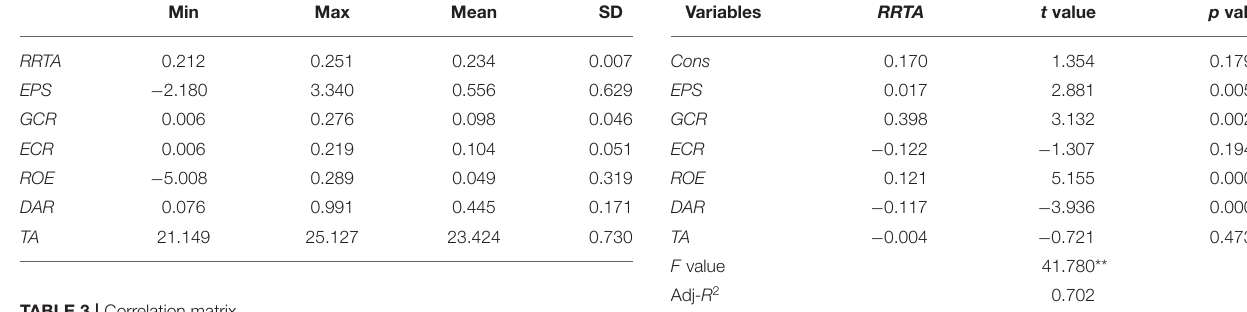
TABLE 3 | Correlation matrix.